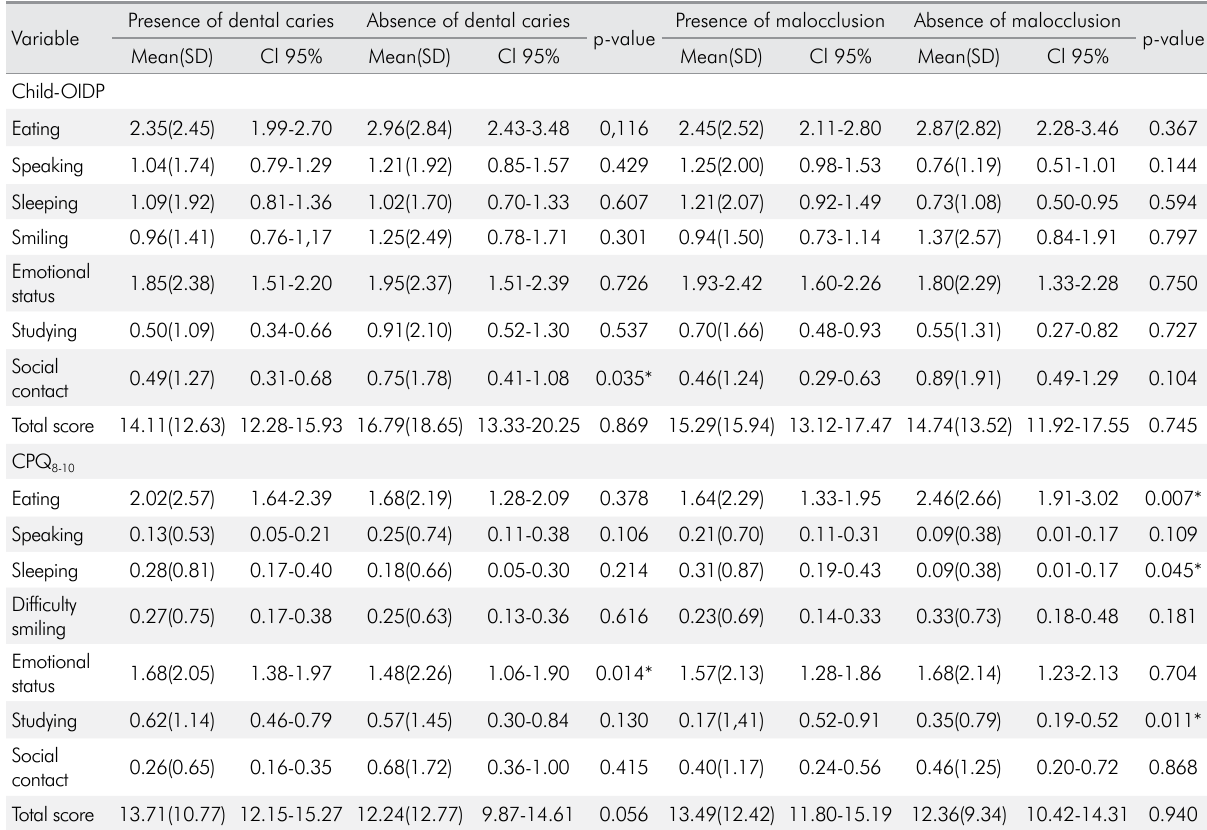
Table 3. Discriminative validity of the child-OIDP and the CPQ and